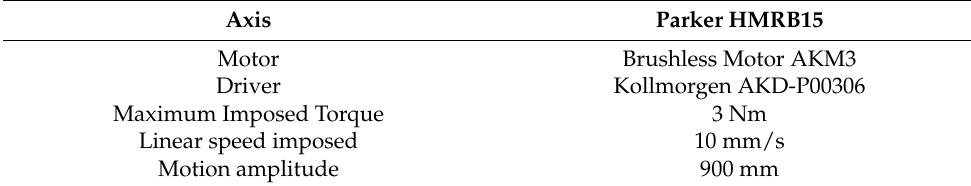
Table 1. Technical characteristics of the linear